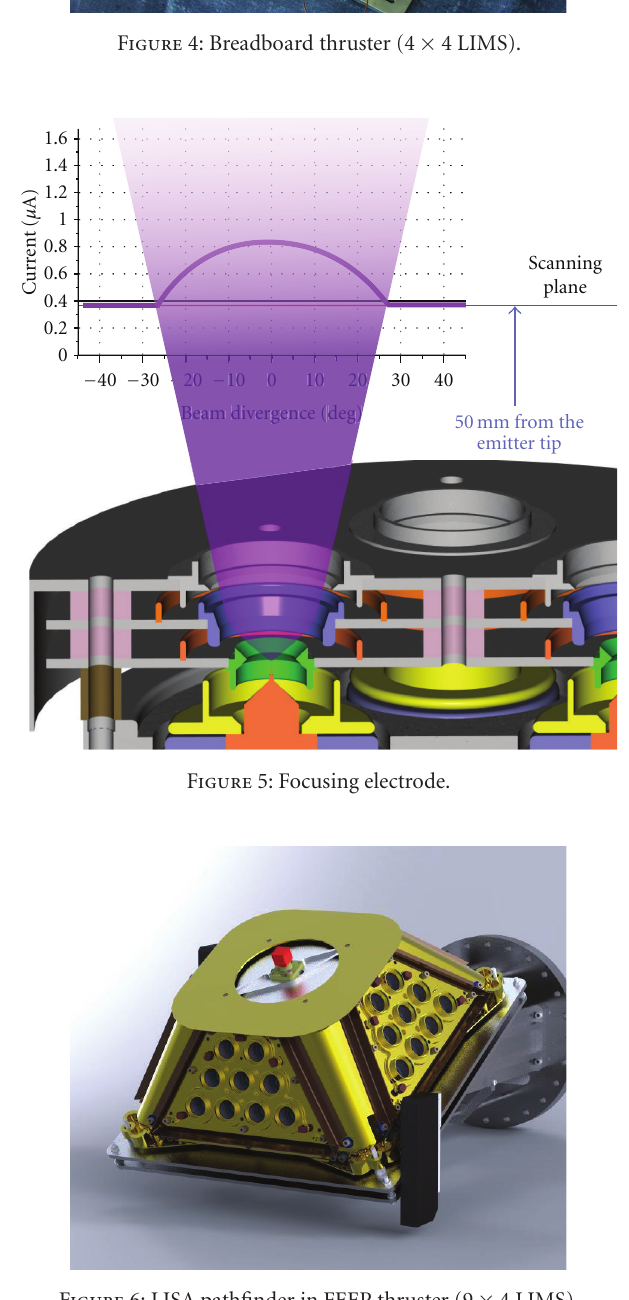
Figure 6: LISA pathfinder in FEEP thruster (9 × 4 LIMS).